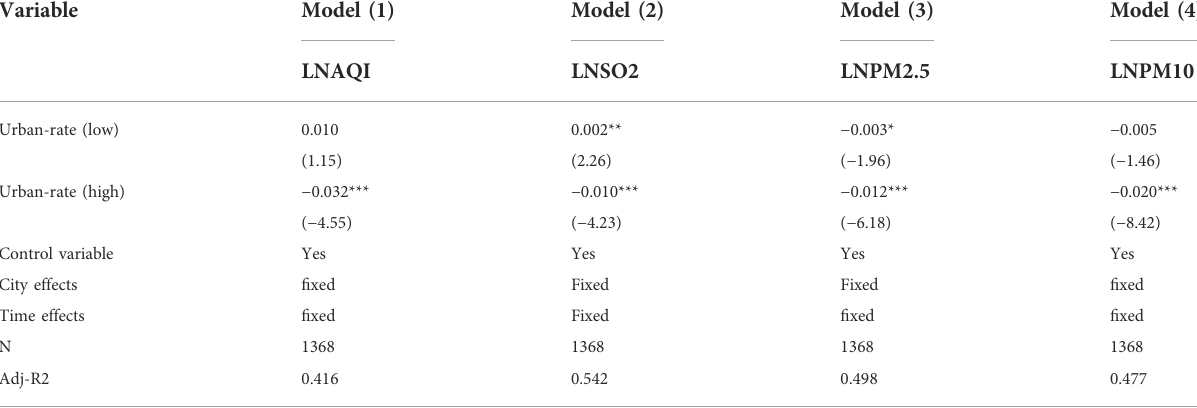
TABLE 8 Threshold effect regression and robust test of the impact of digital economy on urban air